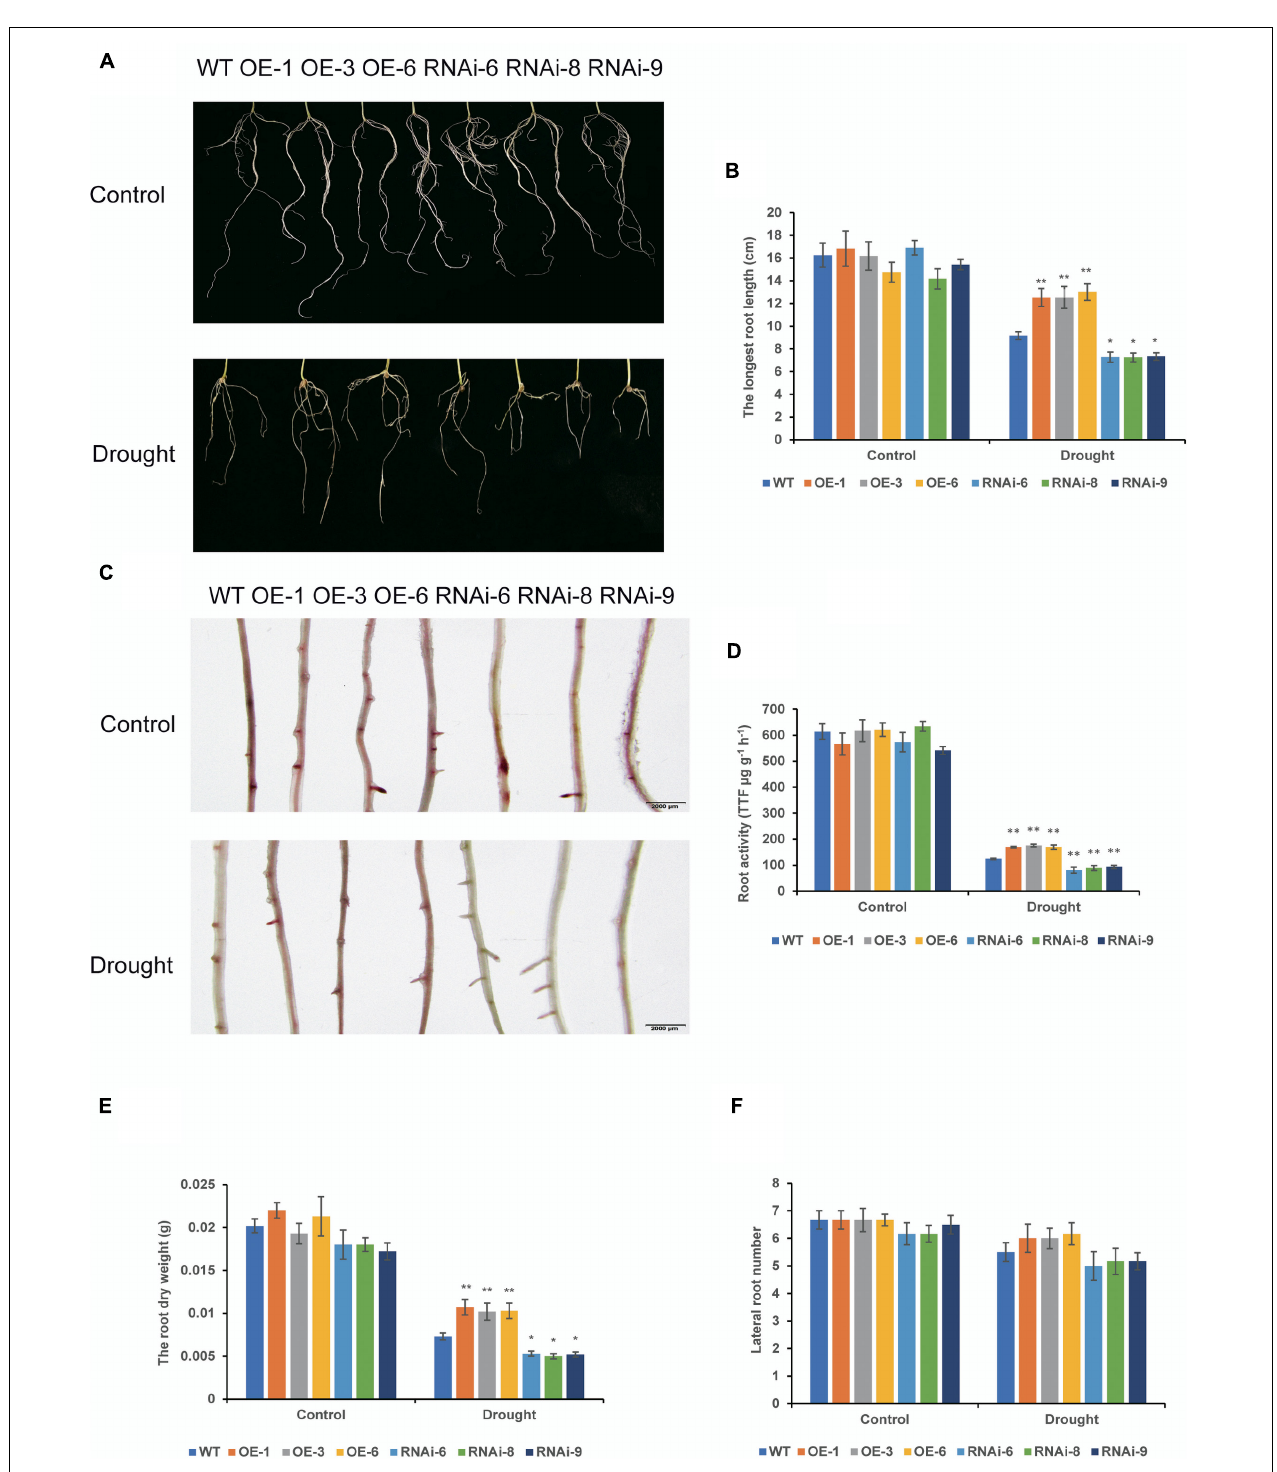
FIGURE 2 | Effect of drought stress on the root system of WT and transgenic wheat at the seedling stage. (A) The roots phenotypes of WT and TaNRX1 transgenic wheat were cultured in 1/2 Hoagland nutrient solution and 1/2 Hoagland nutrient solution with 20% (M/V) polyethylene glycol (PEG6000) for 10 days. (B) The longest root length ( n = 6). (C) 2, 3, 5-triphenyltetrazolium chloride (TTC) staining of roots. Scale bar = 2 mm. (D) Root activity ( n = 3). (E) Root dry weight ( n = 6). (F) Lateral root numbers ( n = 6). Data represent the mean ± SD. WT, wild type; OE-1–OE-6, TaNRX1 overexpression T 3 homogeneous lines; RNAi-6–RNAi-9, TaNRX1 RNA interference T 3 homogeneous lines. * P < 0.05, ** P < 0.01 represent the significant difference between the transgenic line and the WT, respectively.